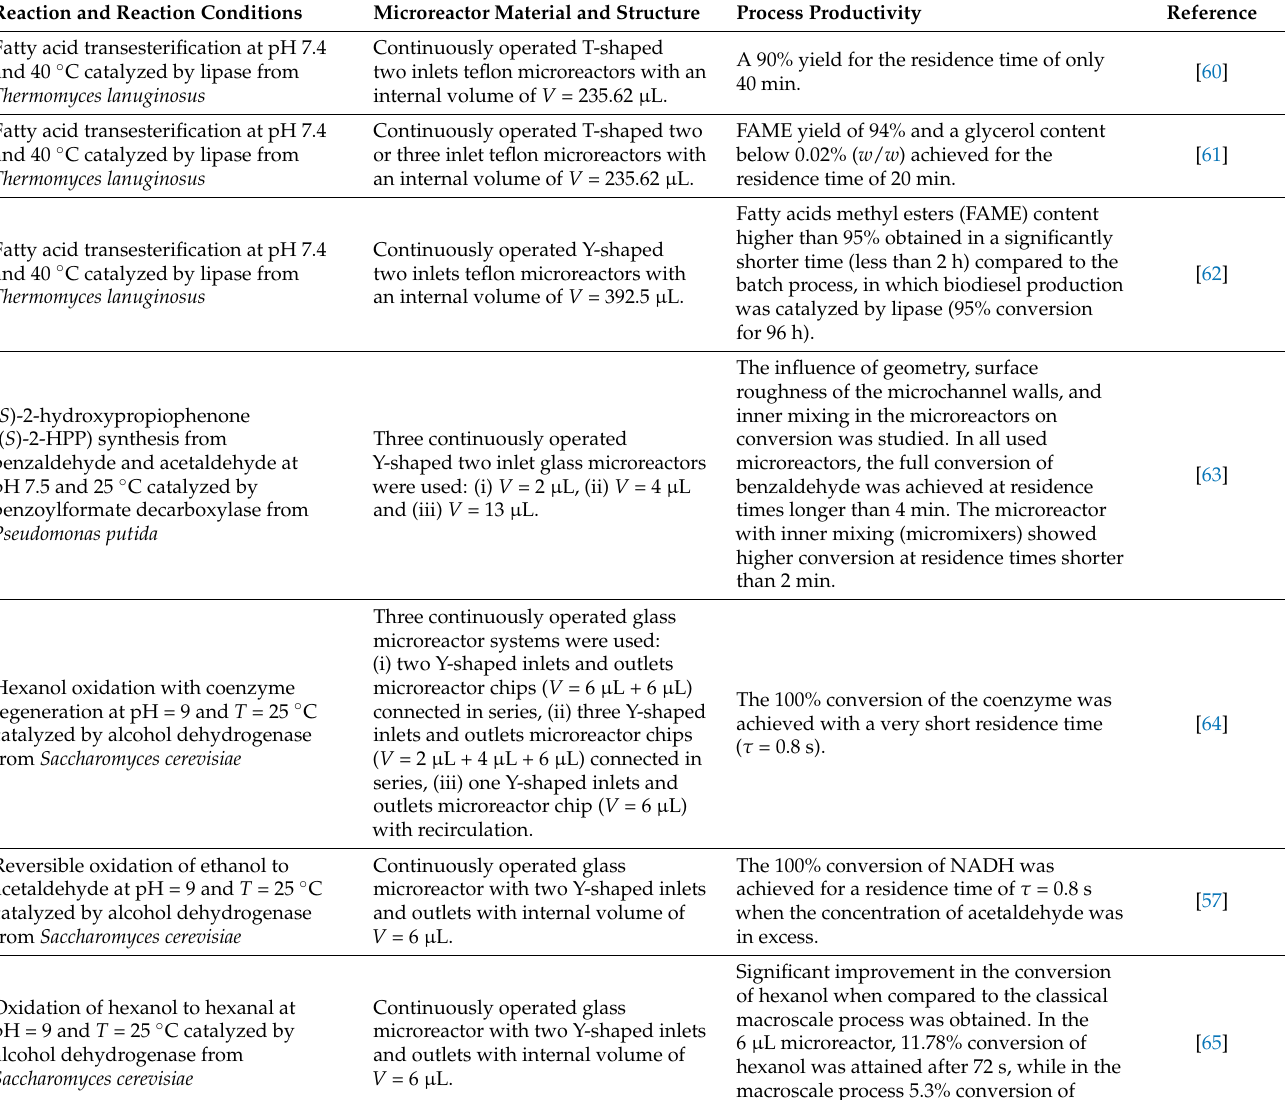
Table 1. Application of microreactors for biotransformation’s with free